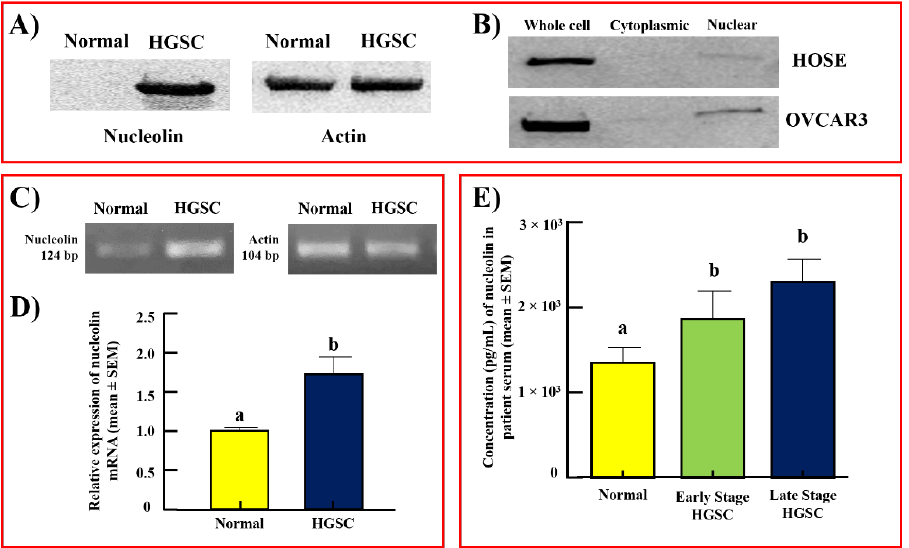
Figure 2. Changes in nucleolin expression during ovarian HGSC development as detected by im- munoblotting, gene expression, and immunoassays. Immunoblot: ( A ) Immunoblot of tumor ho- mogenate from an ovarian HGSC patient showing intense nucleolin expression while normal ovar- ian homogenate shows very faint expression for nucleolin. ( B ) Compared with HOSE (normal ovar- ian epithelial) cells, the immunoblot of whole cell lysate from OVCAR3 (ovarian cancer cell line) showed strong nucleolin expression. Similarly, a stronger signal for nucleolin was observed in the nuclear fraction from cancer cells (OVCAR3) than in normal ovarian (HOSE) cells. Gene expression assays: ( C ) RT-PCR assays showed stronger expression of NCL (nucleolin gene, 124 bp) in ovarian HGSC tumors than in normal ovaries. ( D ) Quantitative RT-PCR assay showing bars representing the expression of NCL in normal ovaries ( n = 3) and ovarian HGSC ( n = 5). Compared with normal ovaries, expression of the NCL gene was significantly higher in ovarian HGSC. Bars with different letters are significantly different in their expression of the NCL gene ( P < 0.05). Immunoassays: ( E ) Bar graph representing the serum levels of nucleolin in subjects with normal ovaries ( n = 8) and patients with early- ( n = 5) and late-stage ( n = 5) HGSC. Compared with normal subjects (1400 ± 105 pg/mL), the concentration of serum nucleolin was approximately 1.5- and 1.7-fold higher ( P < 0.05) in the serum of patients with early- and late-stage ovarian HGSC, respectively. Bars with different letters are significantly different in their serum levels of nucleolin (normal vs. early P < 0.05; normal vs. late P < 0.05). Actin served as a loading control. Bp = base pair. Semiquantitative RT-PCR showed stronger expression of the nucleolin gene ( NCL) in ovarian HGSC than in normal ovaries (Figure 2C). Similarly, qRT-PCR showed a signifi- cant ( P < 0.05) increase in NCL (approximately 1.75-fold) expression in ovarian HGSC compared with normal ovaries (Figure 2D). These results further confirmed the increase in nucleolin expression during the development of ovarian HGSC, as observed in the im- munohistochemical and immunoblotting studies. 3.2. Serum Levels of Nucleolin The immunoassay detected the prevalence of nucleolin in sera of women with or without OVCA. Nucleolin in the sera of healthy women was 1400 ± 105 pg/mL (mean ± SEM). Compared with healthy subjects, the serum level of nucleolin increased to approx- imately 1.5-fold in patients with early-stage ovarian HGSC ( P < 0.05) and increased further in patients with late-stage disease (1.7-fold, Figure 2E). Thus, an increase in tissue expres- sion of nucleolin during ovarian HGSC development and progression is accompanied by an increase in the serum levels of nucleolin.